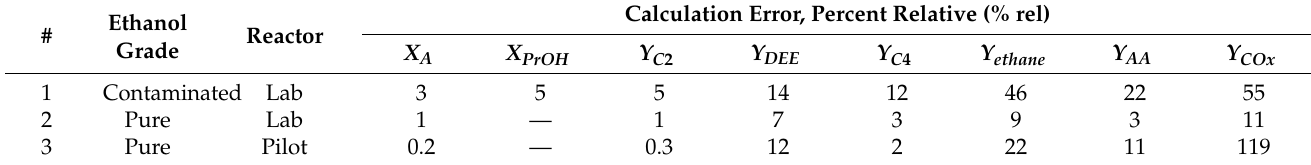
Table 2. Calculation errors.